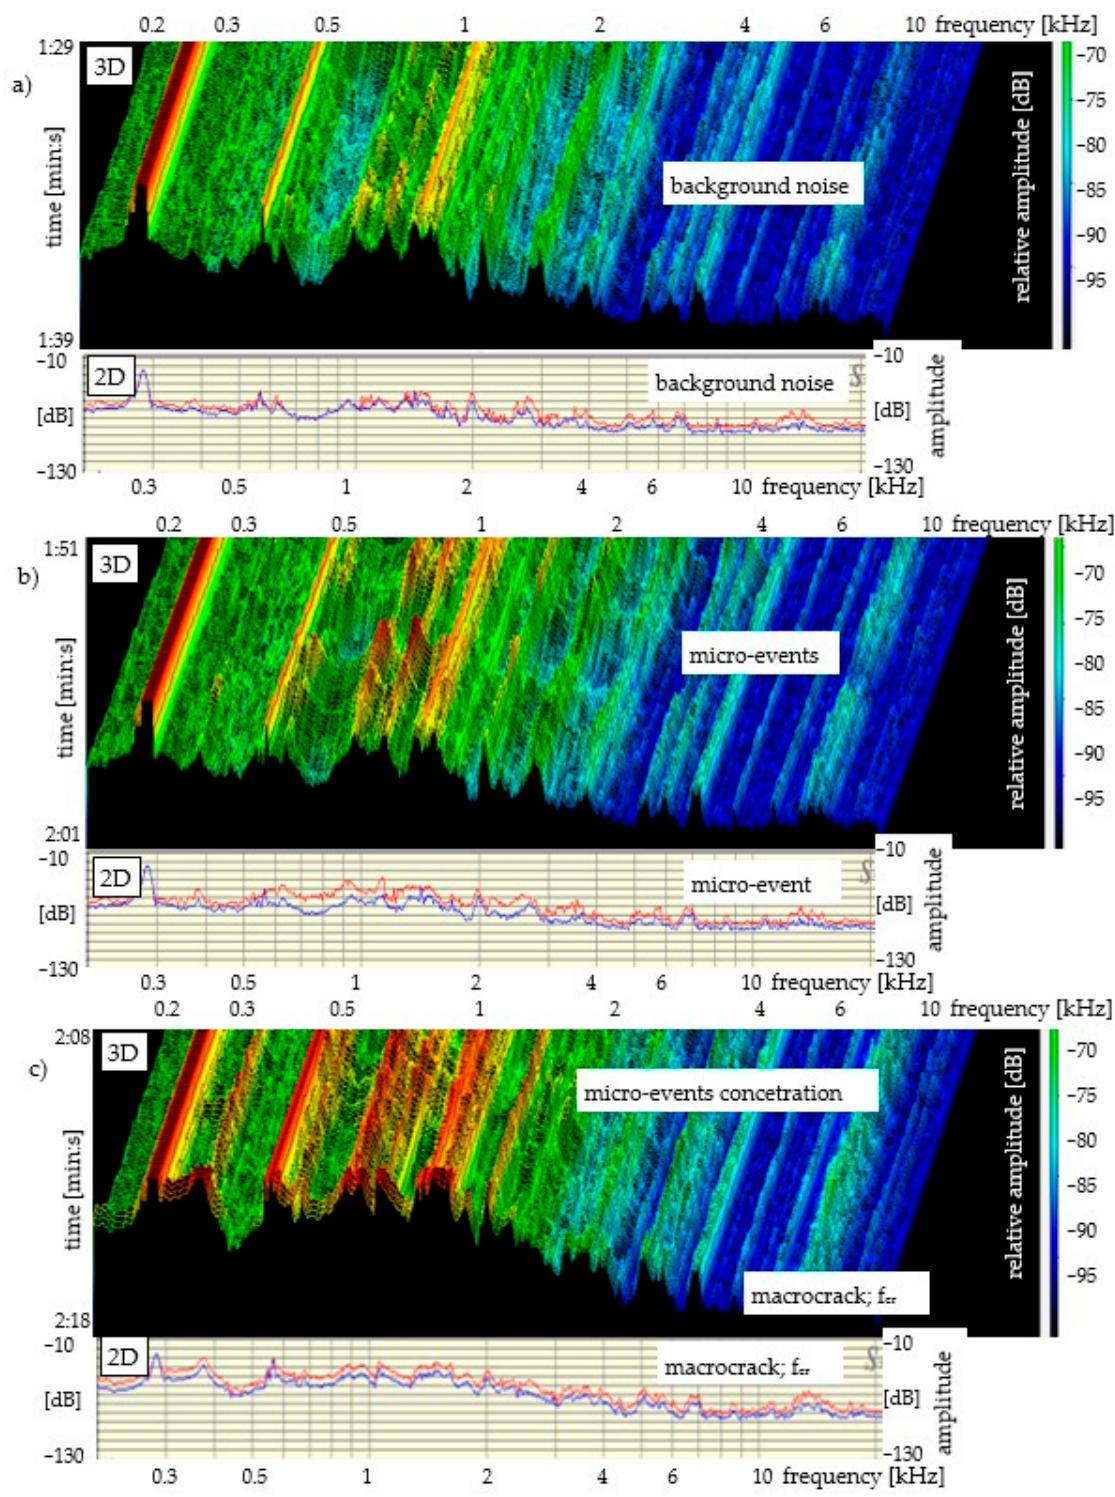
Figure 5. Cement paste with V f = 6% in the bending test and the AE, with 3D and 2D sound spectra: ( a ) background noise; ( b ) micro-events; ( c ) f cr and micro-events concentration.